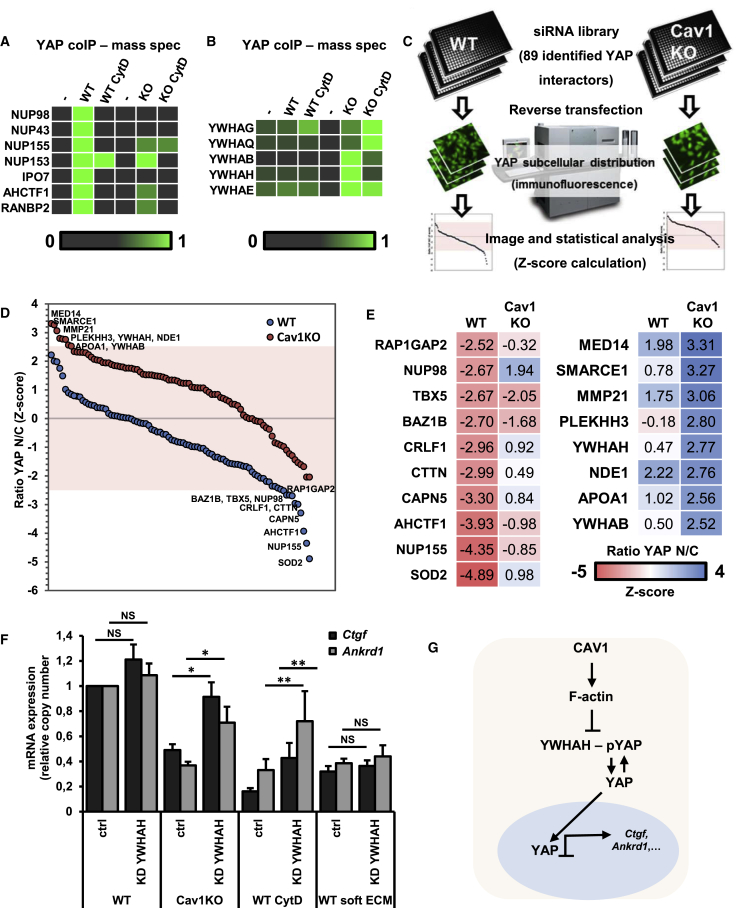
The YAP Interactome Is Altered in Cav1KO MEFs(A and B) Mass spectrometry analysis of YWHA proteins (A) and nuclear pore components and nucelocytosolic transporters (B) that co-immunoprecipitate with YAP in WT and Cav1KO MEFs treated with or without 1 μM CytD for 24 hr. The heatmap represents the relative number of counts per protein and condition. Negative controls (first and third column) were performed in parallel by omitting the primary anti-YAP antibody. n = 5.(C) siRNA library screening scheme for identifying YAP activity regulators.(D) Plot of mean Z scores of the YAP nuclear-to-cytosolic ratio for each individual siRNA in WT and Cav1KO MEFs.(E) Mean Z score of the YAP nuclear-to-cytosolic ratio in WT and Cav1KO cells after siRNA transfection for those genes whose Z scores are above 2.5 or below −2.5. n = 3.(F) qRT-PCR of Ctgf and Ankrd1 in cells transfected with control or YWHAH siRNAs: WT and Cav1KO MEFs, WT cells treated for 24 hr with 1 μM CytD, and WT cells grown on soft substrate. n = 5. Data are presented as means ± SEM. ∗p < 0.05 and ∗∗p < 0.01.(G) Scheme of CAV1-YAP regulation.See also Figures S4 and S5, Table S2, and Data S1.